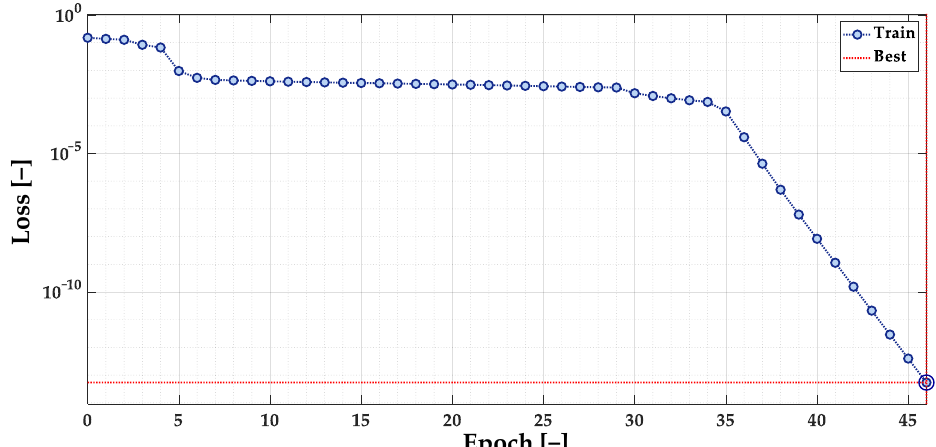
Figure 15. Loss (mean square error) function during the training process of the selected MLP model.